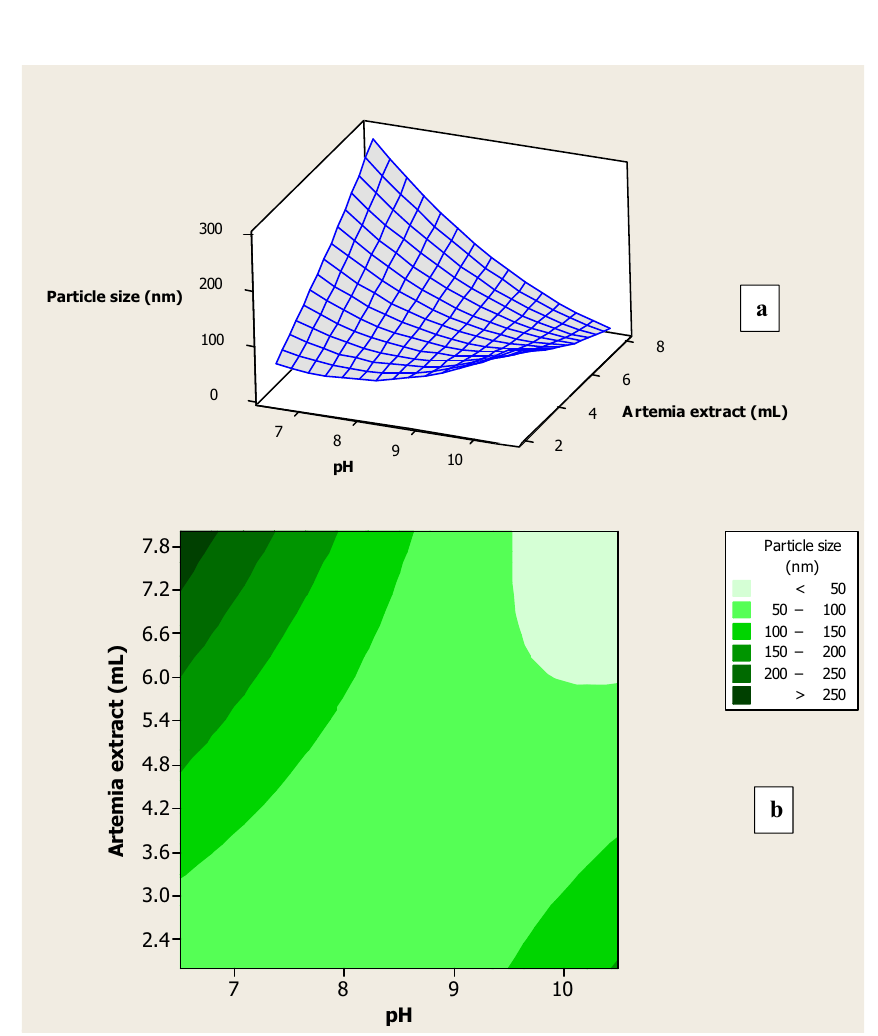
Figure 2: Surface plot ( a ) and contour plot ( b ) for particle size of the fabricated Au NPs as function of amount and pH of the prepared A. urumiana